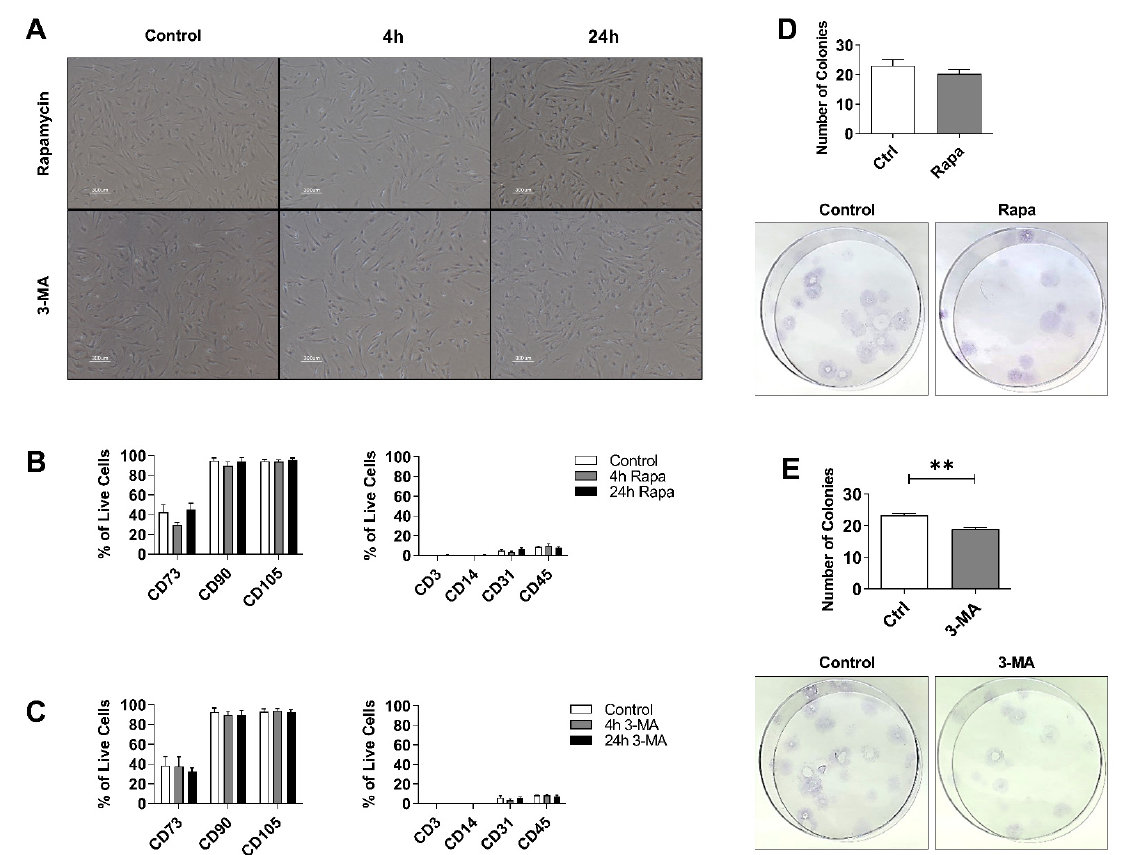
Figure 1. Autophagy preconditioning in hASCs does not alter self-renewal capacity or surface expression of MSC markers. ( A ) Representative images of hASCs morphology in culture after both short= and long-term exposure to autophagy preconditioning agents. Scale bar= 300 µm. Immunophenotype of Rapa-ASCs ( B ) and 3MA-ASCs ( C ) by flow cytometric analysis of surface proteins. Data are presented as mean ± SEM of 3 independent experiments. Quantifaction and images of colony-forming units by Rapa-ASCs ( D ) and 3MA-ASCs ( E ). Data are presented as mean ± SEM of 4 independent experiments. All data comparing 3 groups are analyzed by using one-way analysis of variance (ANOVA) with Tukey’s post-hoc multiple comparisons, and CFU-F data are analyzed with unpaired student’s t -test. Abbreviations: Rapa, Rapamycin; 3-MA, 3-methyladenine; CFU-F, colony forming units-fibroblasts. ** p < 0.01.